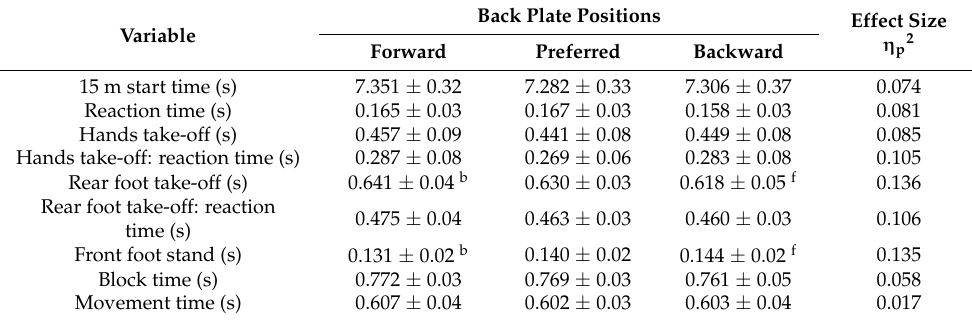
Table 2. Mean ± SD of the temporal variables of swimming start performed by female swimmers presented separately for each starting position and complemented with significant results exposed through statistical procedures.